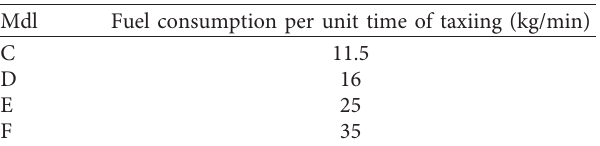
Table 7: Fuel consumption per unit time of taxiing for different types of aircraft. Mdl